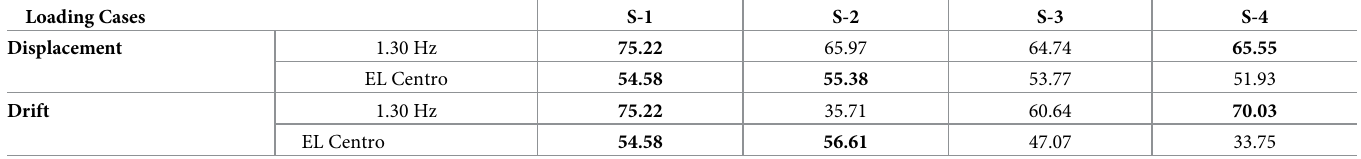
Table 5. Percentage reduction in the RMS displacement and drift responses of MDOF structure with TLCD over uncontrolled MDOF structure. Loading Cases